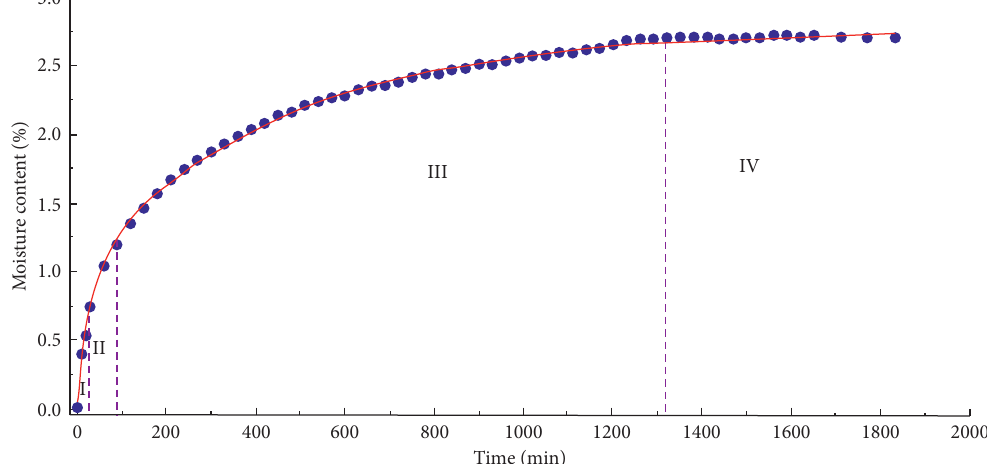
Figure 3: The curve of the moisture content of rock sample changes with time